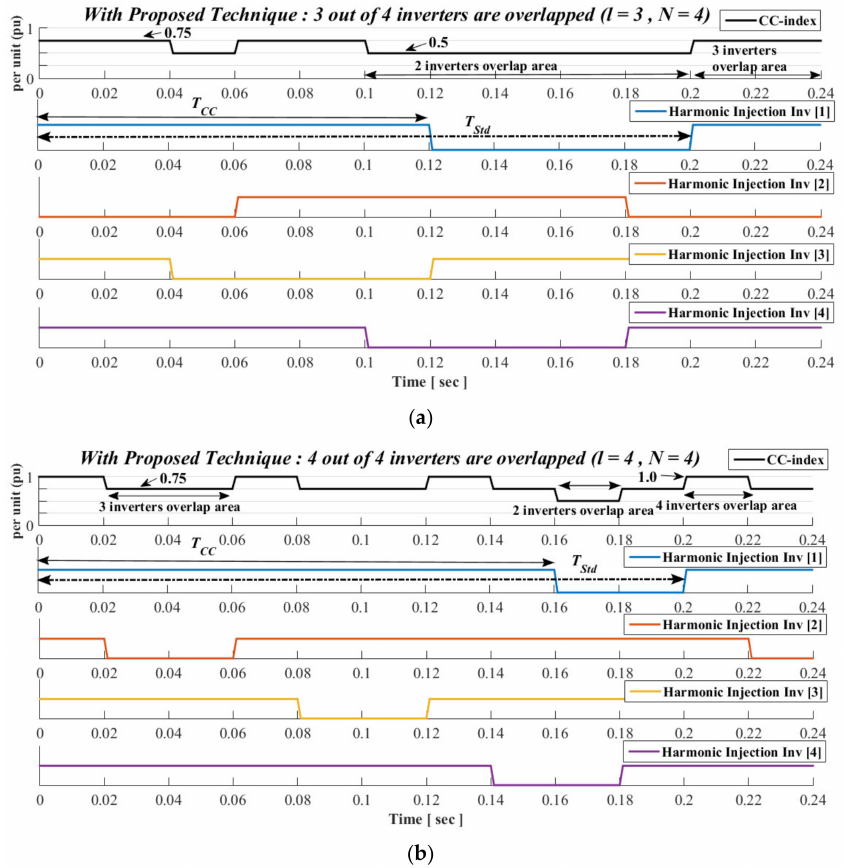
Figure 6. Injection pattern of the N -subgroup inverters and CC index evolution in a time domain for, ( a ) N = 4 and l = 3 (implying that at least three inverters will be overlapped), ( b ) N = 4 and l = 4 (implying that at least four inverters will be